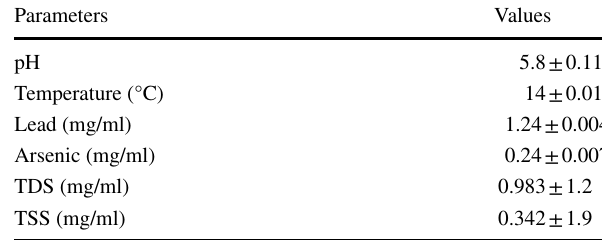
Table 1 Physicochemical properties of industrial